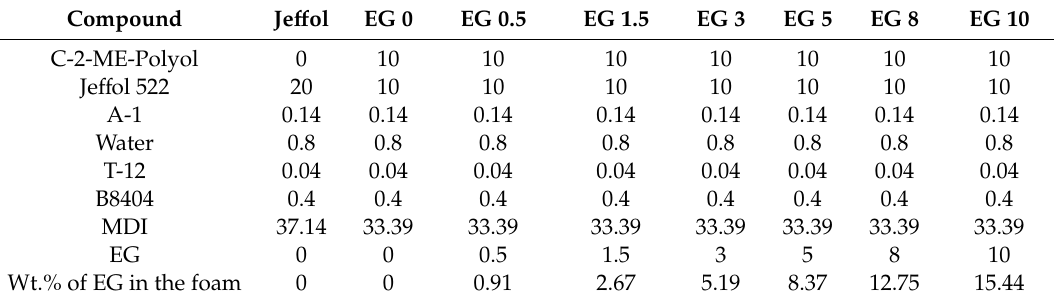
Table 1. The formulation in grams of foam’s